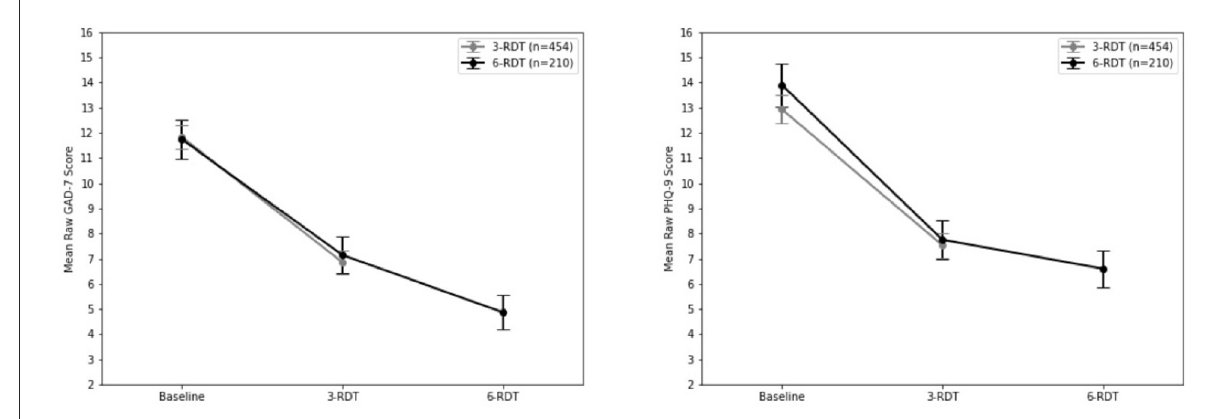
FIGURE2 Mean GAD-7 and PHQ-9 scores at baseline, after 3-RTD, and 6-RDT ketamine